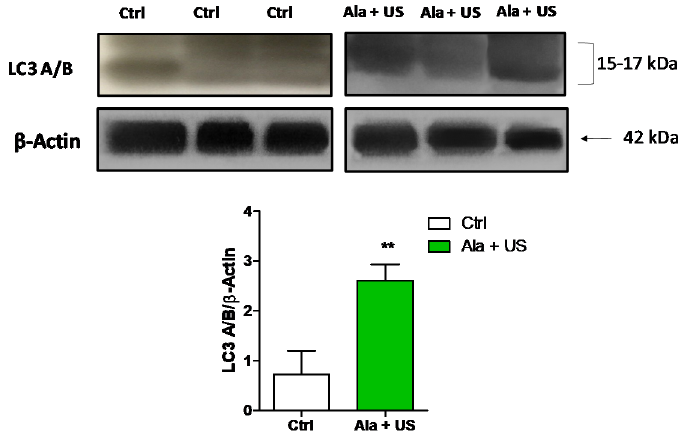
Figure 6. LC3 A/B protein expression after SDT. Control and experimental groups were either treated with a saline iv injection into the tail vein (0.5 mL), an Ala iv injection into the tail vein (375 mg/kg bw), US alone (1.5 W cm 2 , 1.8 MHz, 300 s), or Ala and US (1.5 W cm 2 , 1.8 MHz for 300 s, at 4 h after the Ala 375 mg/kg bw iv injection, SDT group). Representative Western blots of LC3 A/B protein expression at 72 h after SDT. Histograms report densitometric analysis normalized for the corresponding β-actin content. Statistical significance vs. untreated tissue (Ctrl): ** p ≤ 0.01.